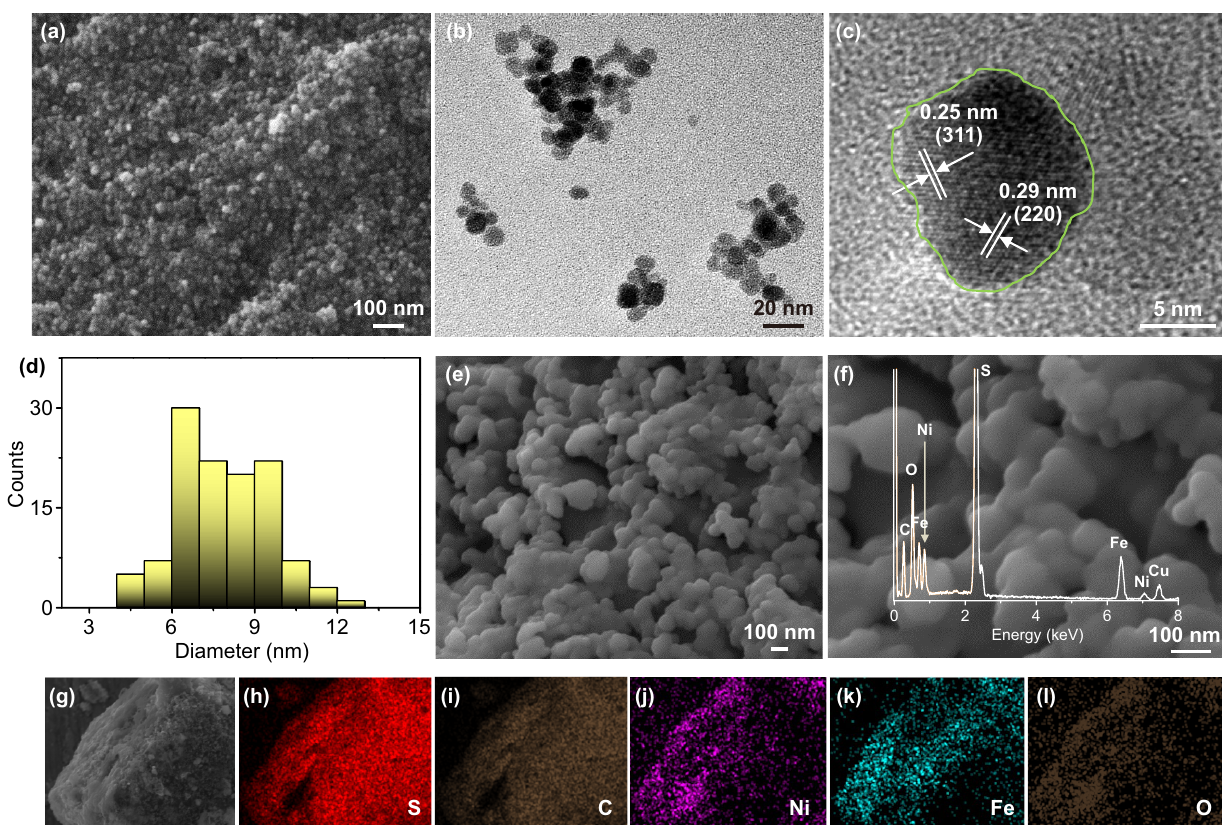
Fig. 2 a Basic SEM, b , c TEM observations, and d size-distribution plot of NiFe 2 O 4 QDs. e , f SEM images (inset: EDS spectrum) and g – j elemental mappings of S@CB ⊆